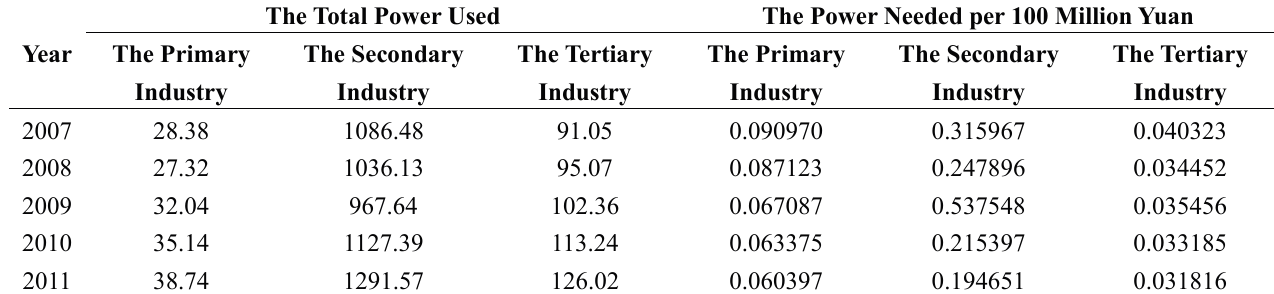
Table 4. The total power used and the power needed per 100 million yuan in Shanxi Province from 2007 to 2011 (100 million Kwh) [30–34].